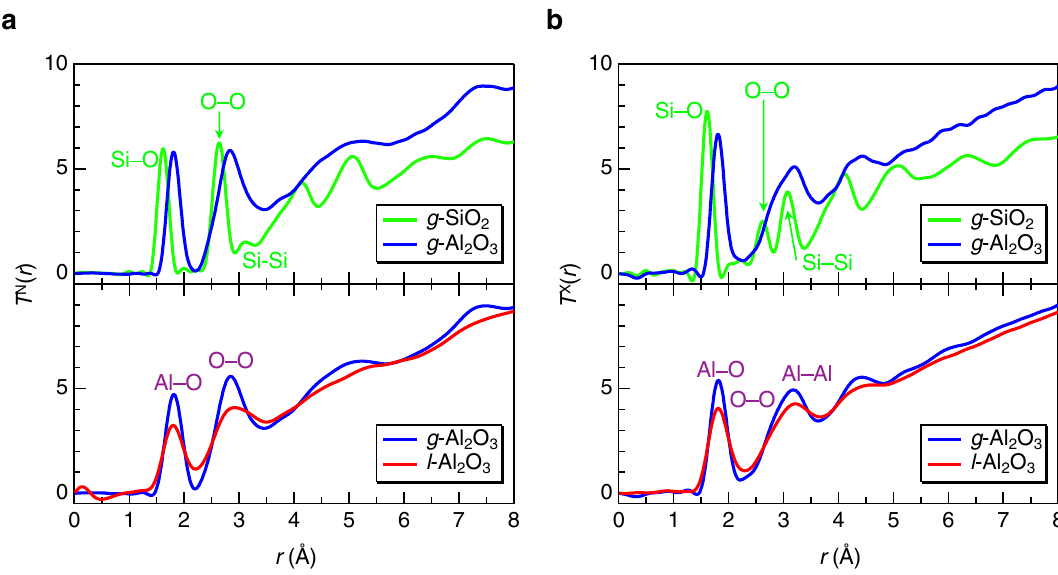
Figure 3. ( a ) Neutron total correlation functions, T N ( r ), for g -Al 2 O 3 , l -Al 2 O 3 33 , and g -SiO 2 5 . ( b ) X-ray total correlation functions, T X ( r ), or g -Al 2 O 3 , l -Al 2 O 3 33 , and g -SiO 2 5 . Upper and lower panel data were obtained by Fourier transform with Q max = 25 and 18 Å −1 , respectively. Note that the Al–Al correlation peak is not legibly marked owing to its small weighting factor for